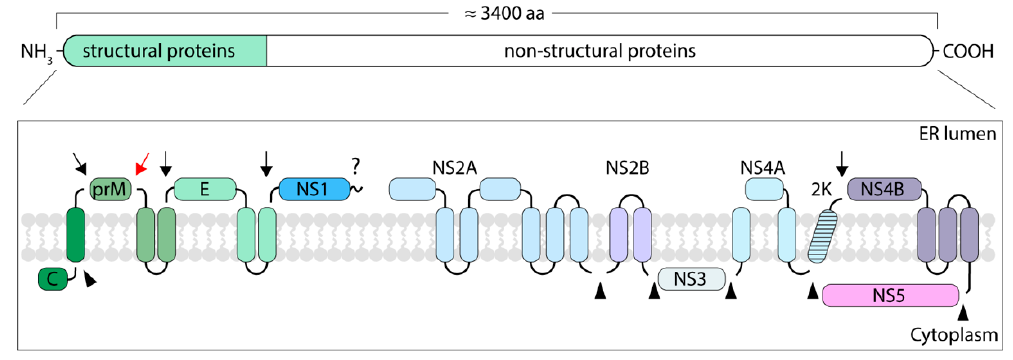
Figure 6. Schematic representation of the flavivirus polyprotein and its cleavage products. Structural proteins are shown in shades of green and non-structural proteins are shown in shades of blue, shades of violet, and in pink. Black arrows indicate viral serine protease cleavage sites, triangles indicate host signal peptidase cleavage sites, the question mark indicates the cleavage site of an unknown host protease, and the red arrow indicates a furin cleavage site. The ER membrane is shown in grey and the ER lumen and the cytoplasm are indicated.